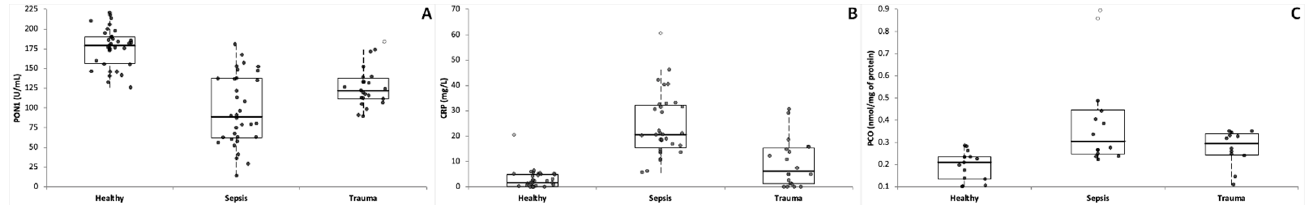
Figure 1. Serum PON1 activity ( A ) and concentration of CRP ( B ) and PCO ( C ) in clinically healthy dogs, in dogs with sepsis and in those with polytrauma. The boxes indicate the I-III interquartile range (IQR), the horizontal black line indicates the median values, whiskers extend to further observation within quartile I minus 1.5 × IQR or to further observation within quartile III plus 1.5 × IQR. Black dots indicate the results that are not classified as outliers. White dots indicate near outliers (values exceeding the third quartile ± (1.5 × IQR)) and grey dots indicate far outliers (values exceeding the third quartile ± (3.0 × IQR)).